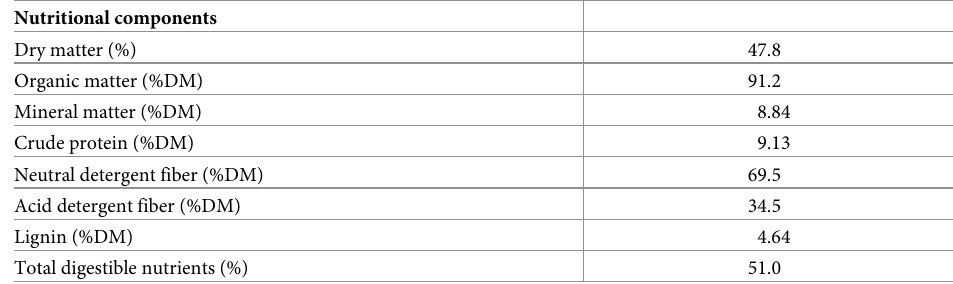
Table 3. Chemical composition of the leaf fraction of the pasture available for cows and calves during the lacta- tion period. Nutritional components